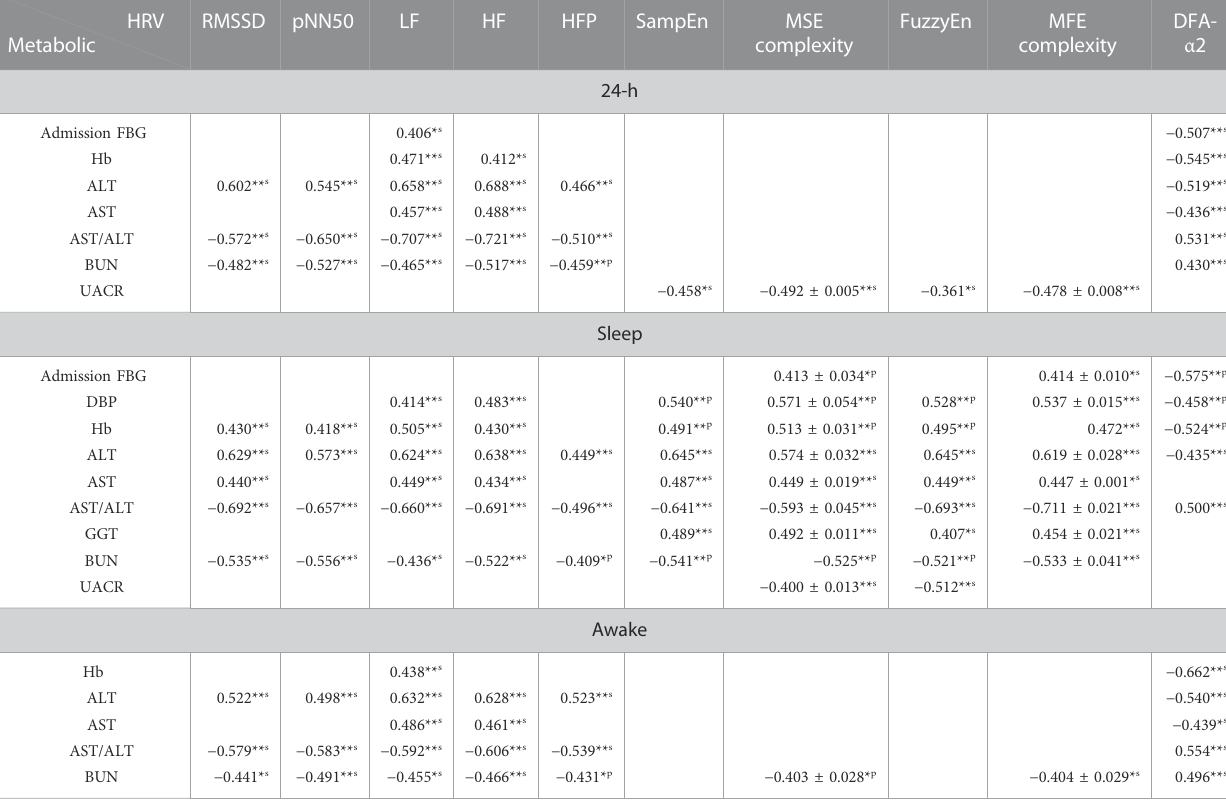
Table 7 demonstrates correlation coef fi cients between non- linear HRV metrics in three sleep stages and glycemic control indicators including admission FBG, discharge FBG and HbA1c.